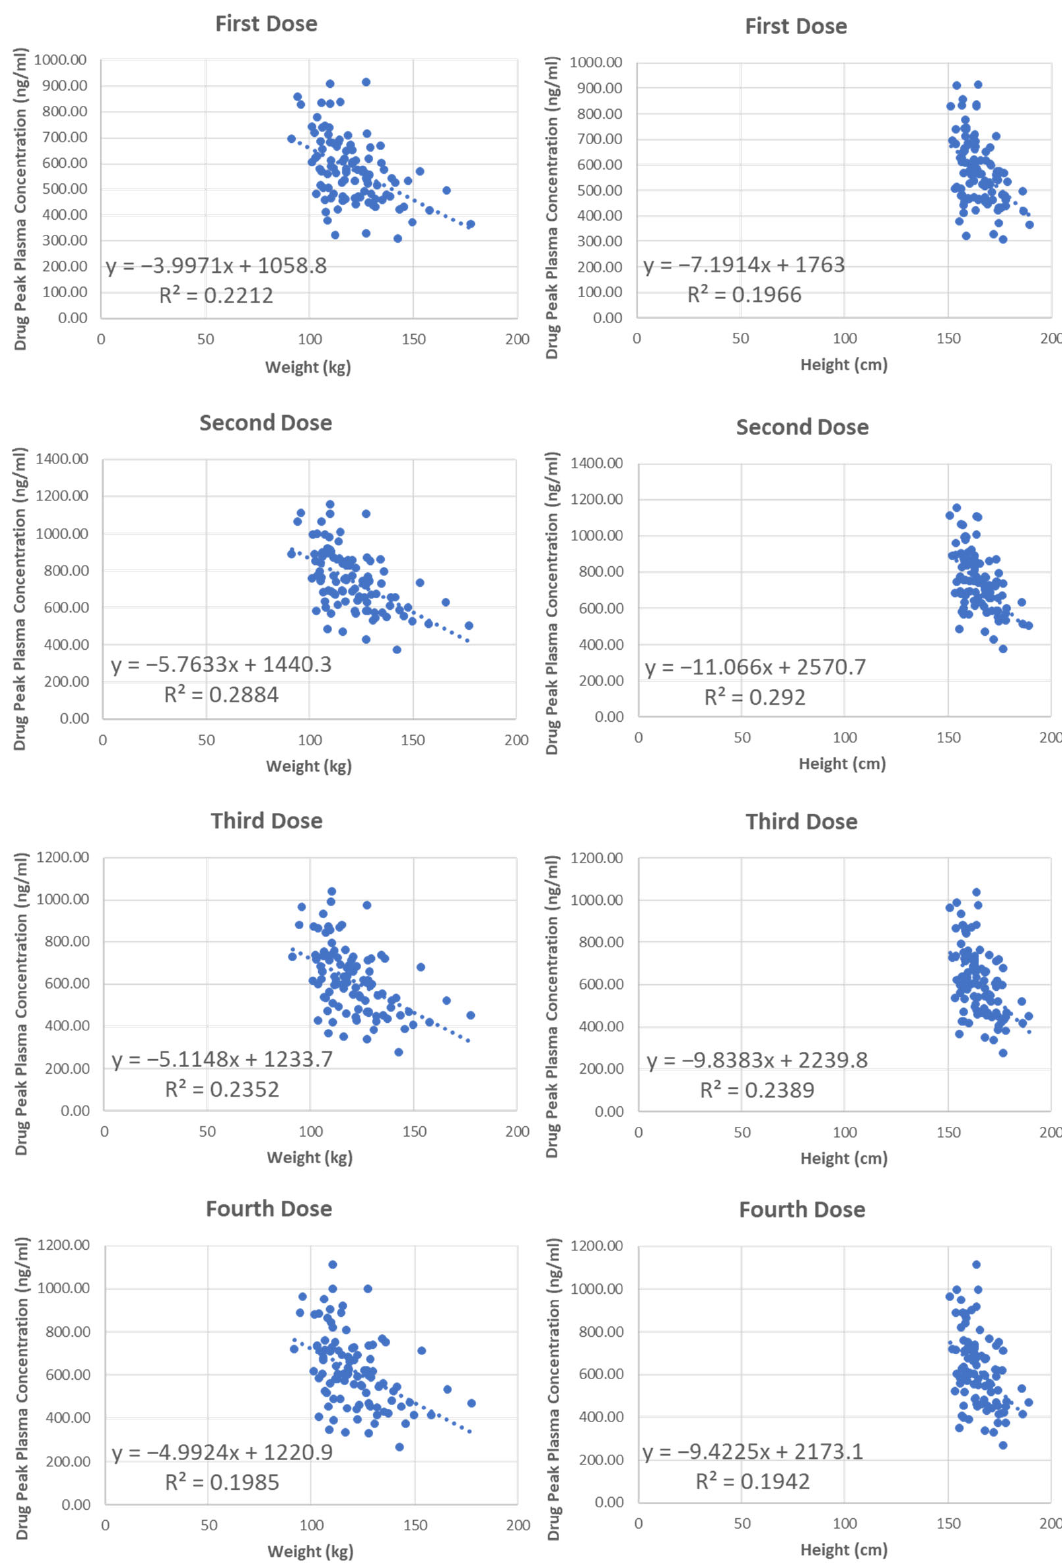
Figure 10. The linear regression models for MO population between individual physical parameters (weight and height) and drug peak concentrations after four doses. The x -axis represents the body weight, and the y -axis represents the peak plasma drug concentration after each dose.